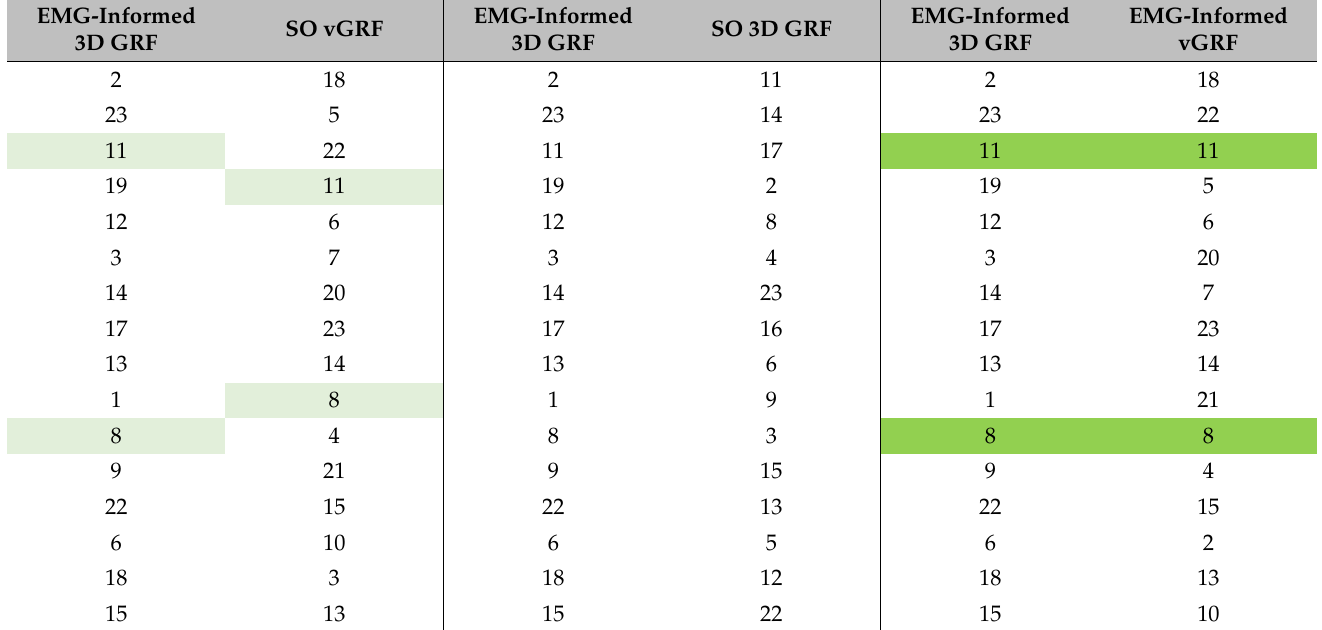
Figure 3. Relative differences (%) in peak ACL force during barefoot drop–land–jump between the EMG-informed + 3D GRF and other modelling approaches: EMG-informed + vertical GRF (green), static optimisation + 3D GRF (purple), and static optimisation + vertical GRF (brown). EMG-inf, EMG-informed; vGRF, vertical ground reaction force; SO, static optimisation. Based on their peak ACL force, rank order of participants was compared across modelling approaches (Table 1). No statistically significant correlations in rank order were found between EMG-informed + 3D GRF and the other three configurations (Table 2). Table 1. Ranking of participants based on their peak ACL force developed during drop–land–jump for EMG-informed + 3D GRF and other modelling approaches.